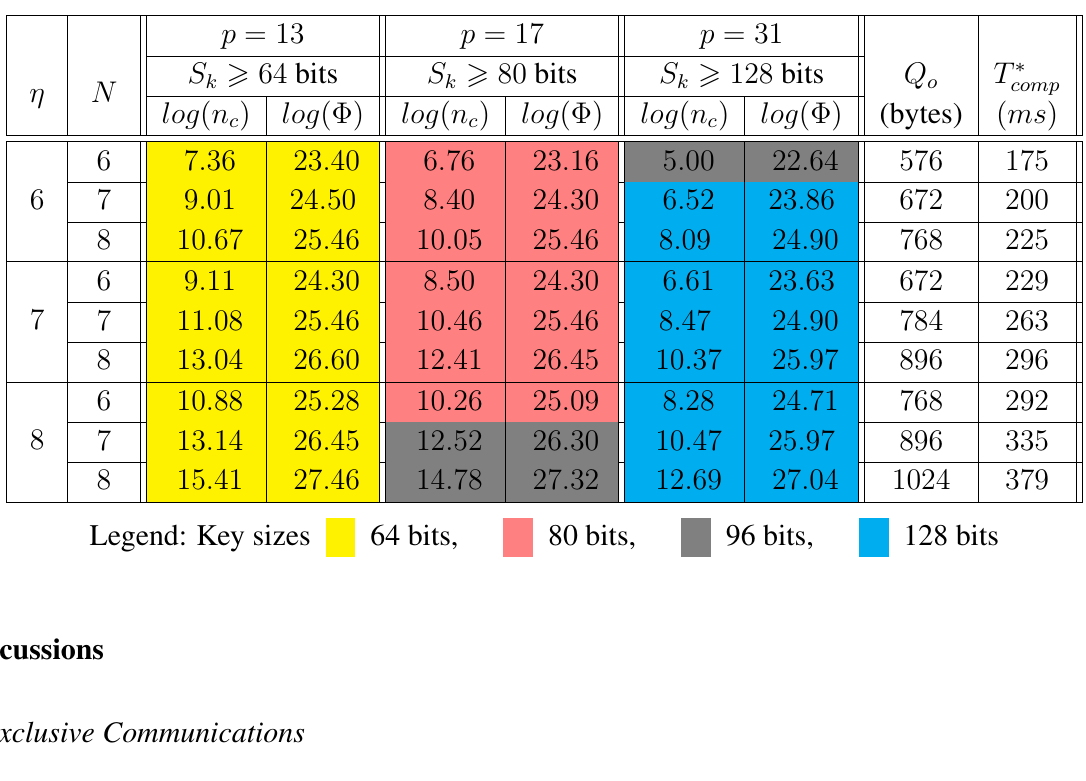
Table 6. Security and performance features using m = 16 . S node capture size n , number of possible master key solutions Φ . ∗ Computation times are c for the MICAz mote with an eight-bit CPU at 8 MHz with 4 KB ROM 4 KB RAM 128 KB